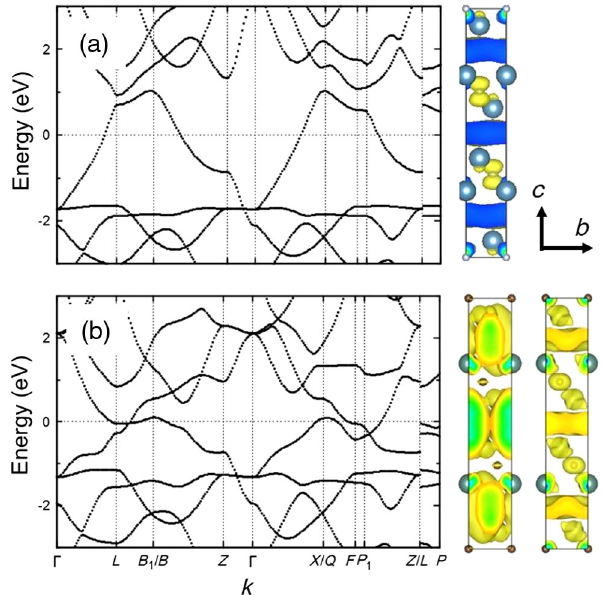
FIG. 3. Calculated energy bands (left) and PED isosurfaces (right) for (a) Ca 2 N and (b) Y 2 C. The PEDs are calculated for states in the energy range − 0 . 05 eV < E < 0 . 05 eV except for the rightmost PED for Y 2 C, which corresponds to an energy range that is 0.3 eV lower, i.e., − 0 . 35 eV < E < − 0 . 25 eV. The PEDs are shown for the conventional unit cell [Fig. 2(a)], and the large (small) spheres denote the cations (anions). See also Fig. 4, which presents the variation of the layer-averaged PED in the c partial electron densities (PEDs) for states within 0.05 eV of the Fermi level ( E F ) are shown in the right panel.